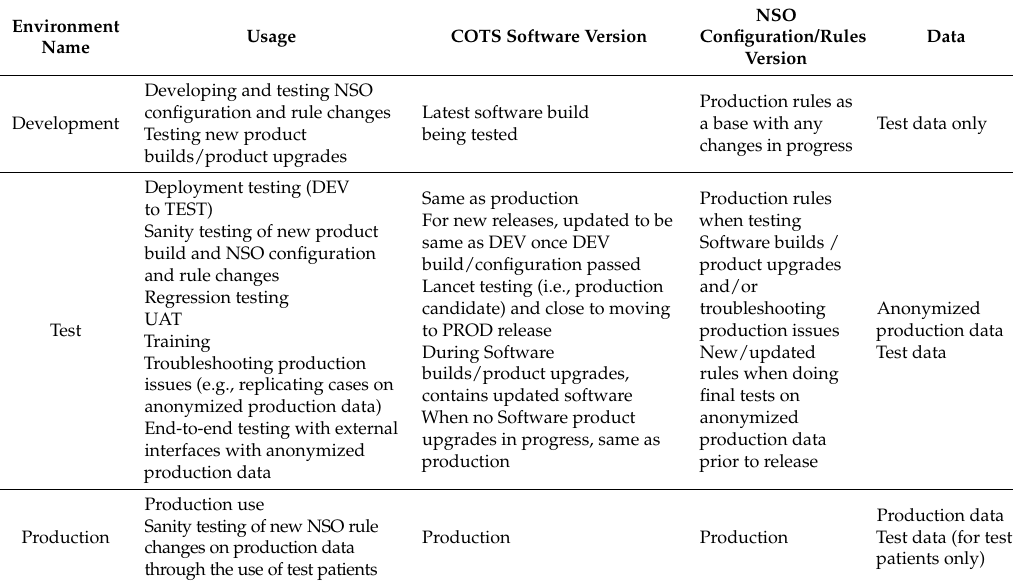
Table 2. NSO Environment